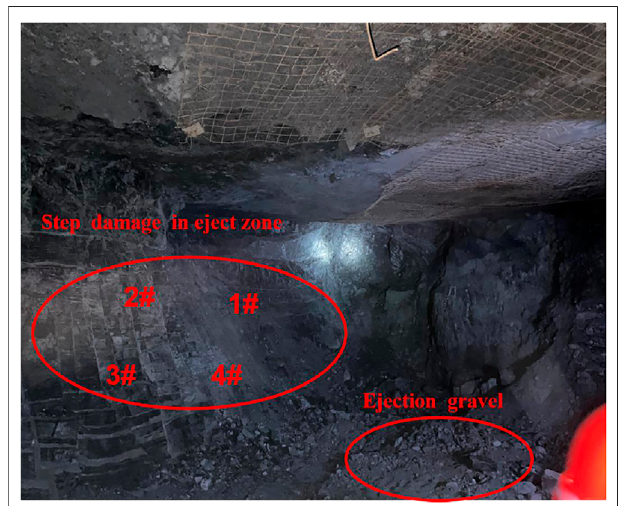
FIGURE 1 | A typical rockburst in